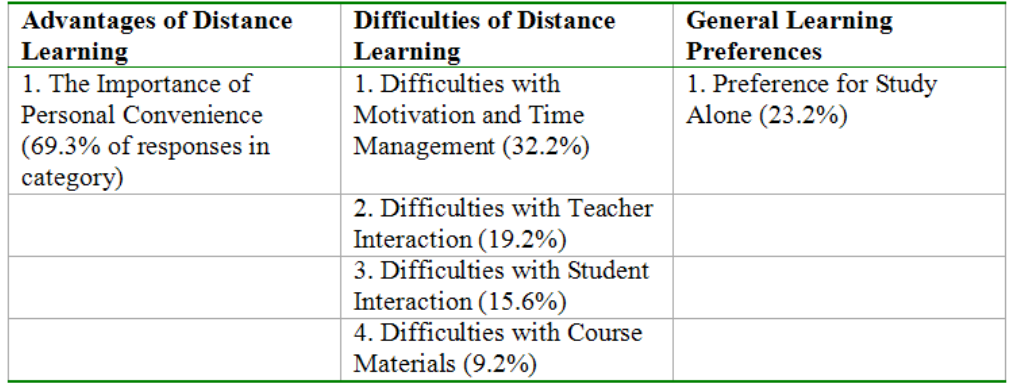
Table 6. Strongest qualitative